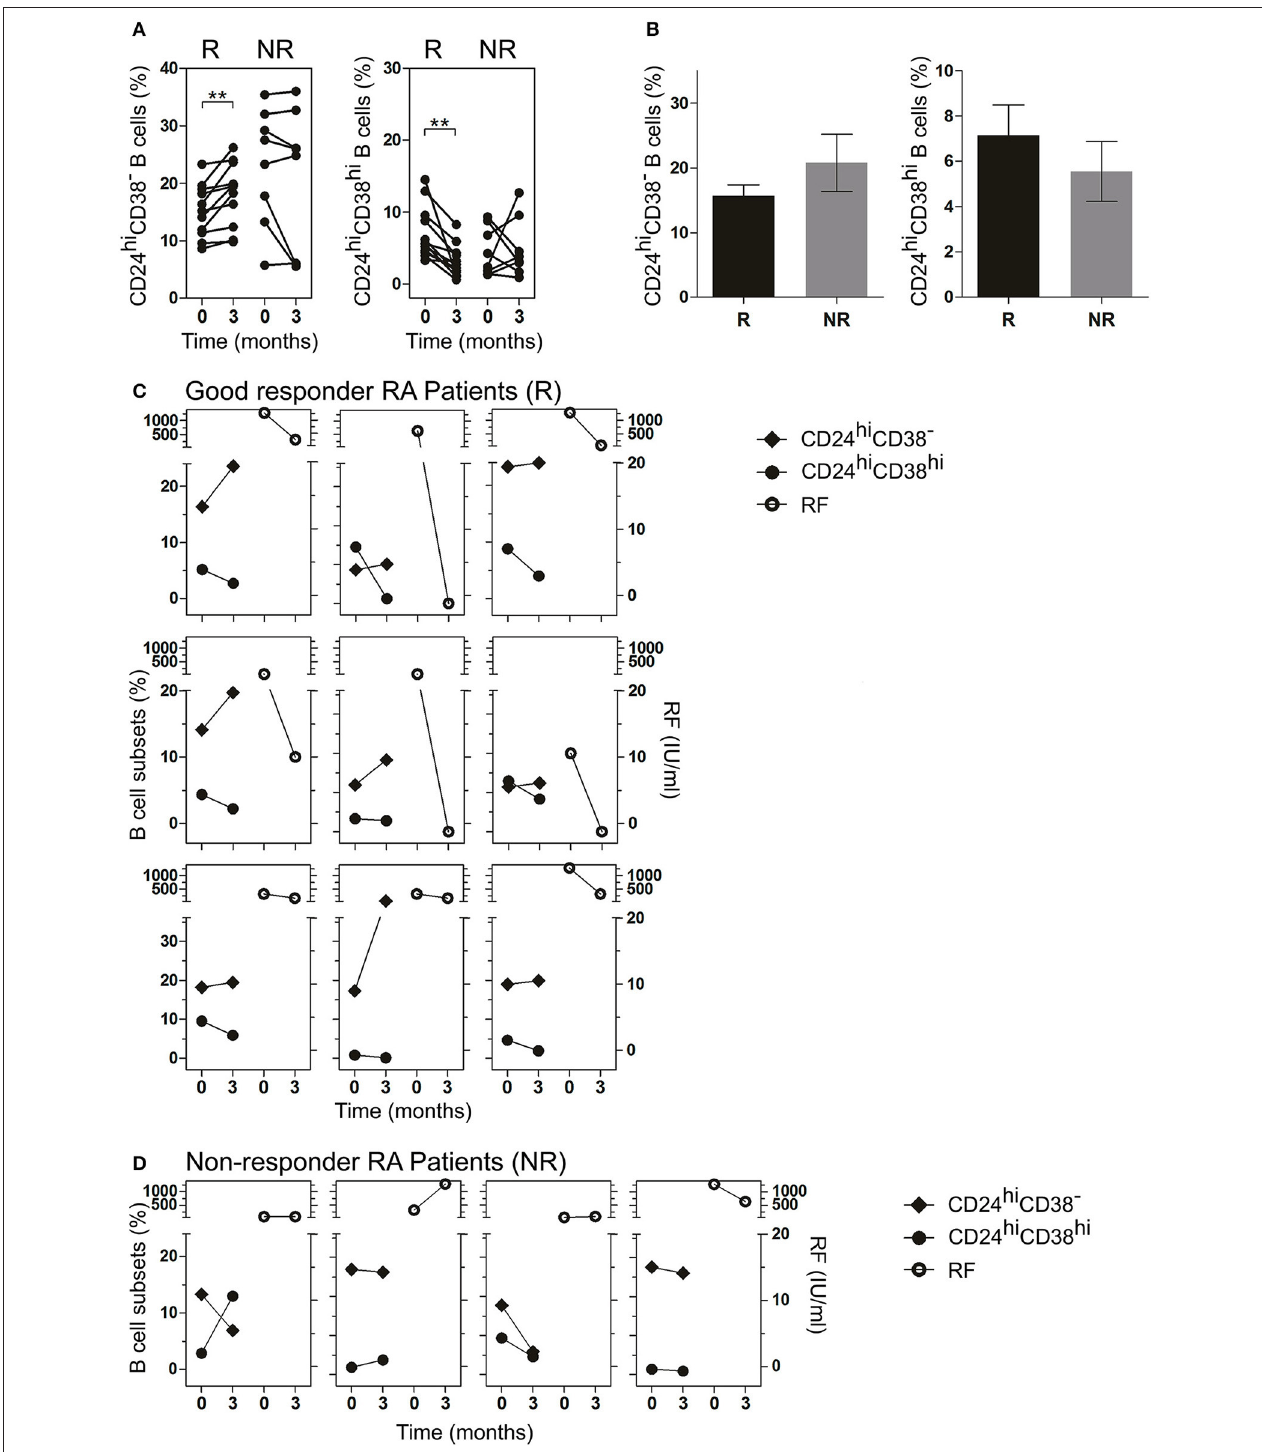
FIGURE 3 | Frequency of CD24 hi CD38 − and CD24 hi CD38 hi B cells in peripheral blood of RA patients at baseline and after treatment. (A,B) Frequency of CD24 hi CD38 − and CD24 hi CD38 hi B cells at baseline (time 0) and after 3 months (time 3) of different treatments (A) or at baseline (time 0) depicted in bars (B) in good responder (R, n = 12) and non-responder (NR, n = 8) patients. ** p < 0.01. P values were determined using the Student’s t -test for paired samples. (C,D) Representative graphs showing the frequency of B cell subsets (left) and rheumatoid factor levels (right) at baseline (time 0) and after 3 months (time 3) of treatment in R patients ( n = 9; C) and NR patients ( n = 4; D) seropositive for RF.